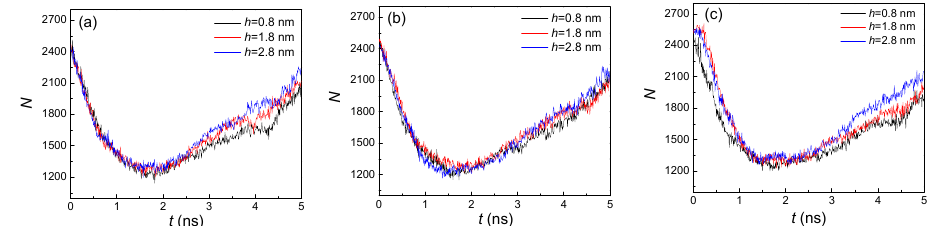
Figure 3. The statistical number of liquid argon atoms with three groove heights; from left to right, the groove widths are ( a ) 1.8, ( b ) 2.4, and ( c ) 3.2 nm on hydrophilic surfaces.